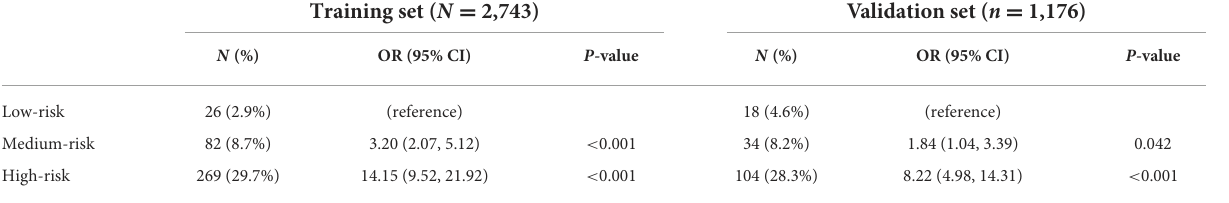
TABLE 3 Odds ratios of delayed extubation in the different risk groups.